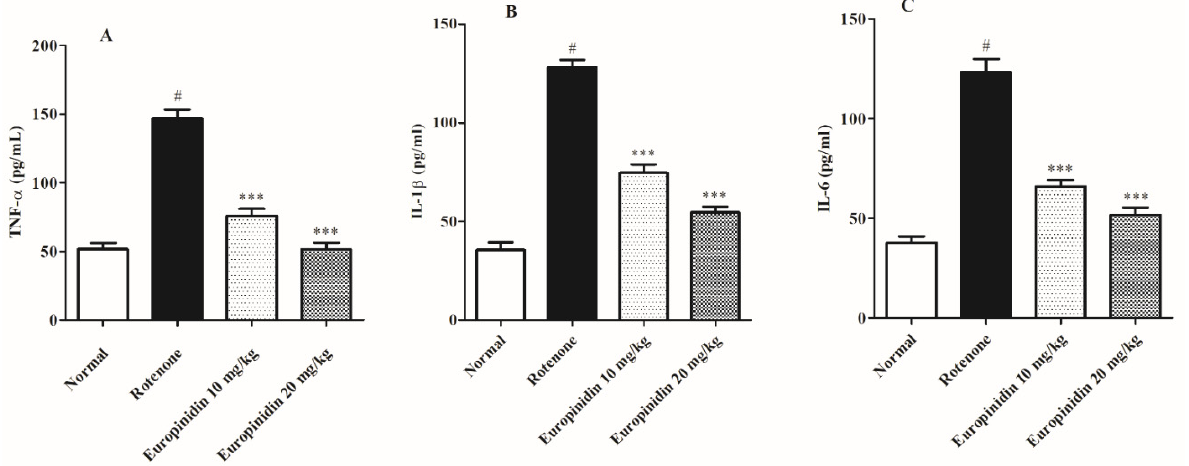
Figure 5. Effect of europinidin on neuroinflammatory parameters. ( A ) TNF-Alpha, ( B ) IL-1ß, ( C ) IL-6. The data were expressed as mean ± S.E.M. ( n = 6/group). *** p < 0.001 when compared with the control group; # p < 0.001 when compared with rotenone group (one-way ANOVA followed by Tukey’s